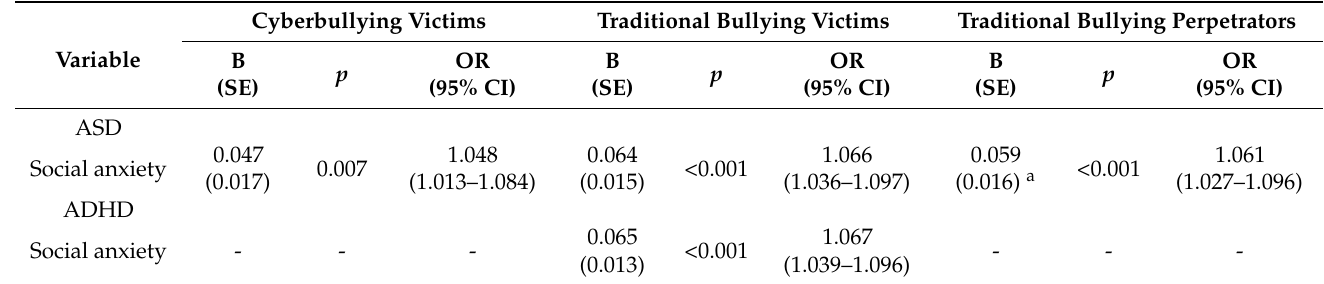
Table 4. Associations of Social Anxiety with Cyberbullying and Traditional Bullying Involvement.